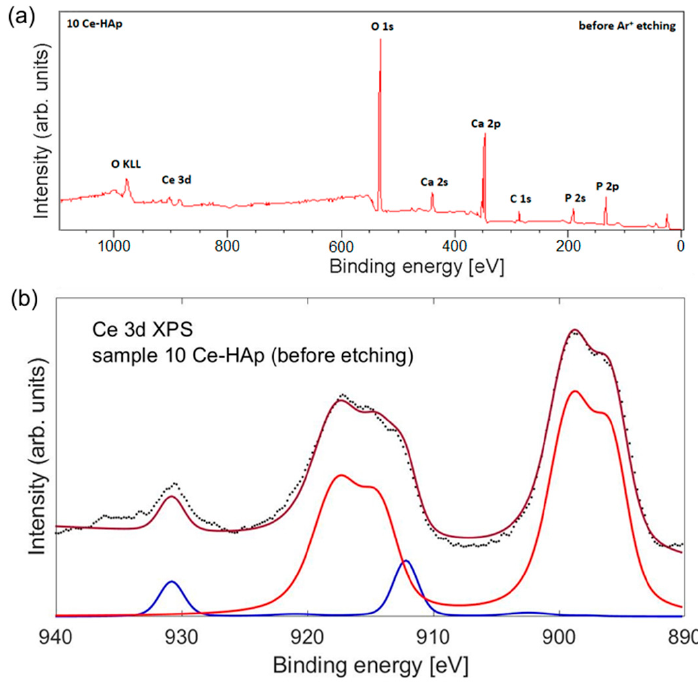
Figure 6. XPS spectra ( a ) and XPS spectrum of Ce (3d) regions ( b ) of the 10Ce-HAp coating before etching. Upper spectra: Data (points) and total fit (brown line) to date after subtraction of a linear background; Lower spectra: Dashed line represents Ce 3+ (red line) and dotted line represents Ce 4+ (blue line).